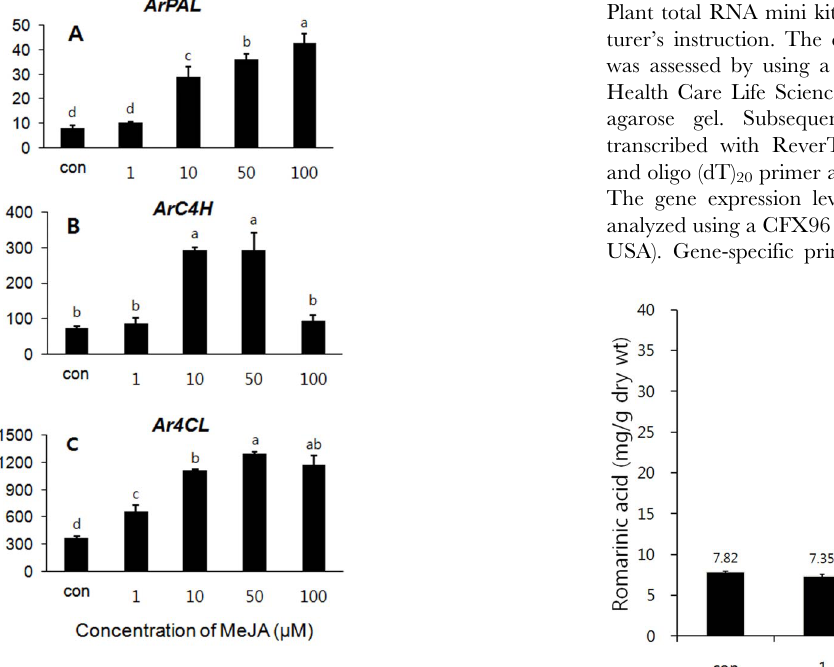
Figure 2. Transcript levels after treatment with methyl jasmonate in suspension cell culture of A. rugosa. Inducible transcript levels of (A) ArPAL , (B) ArC4H , and (C) Ar4CL when treated with different concentrations of MeJA. The longitudinal axis indicates the expression levels of genes relative to that of actin . Each value is the mean of three replicates, and error bars indicate SDs. Values represent LSD (p=0.05).